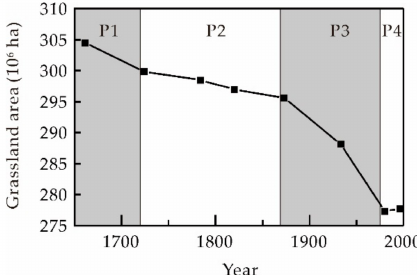
Figure 4. Total grassland area across western China between 1661 and